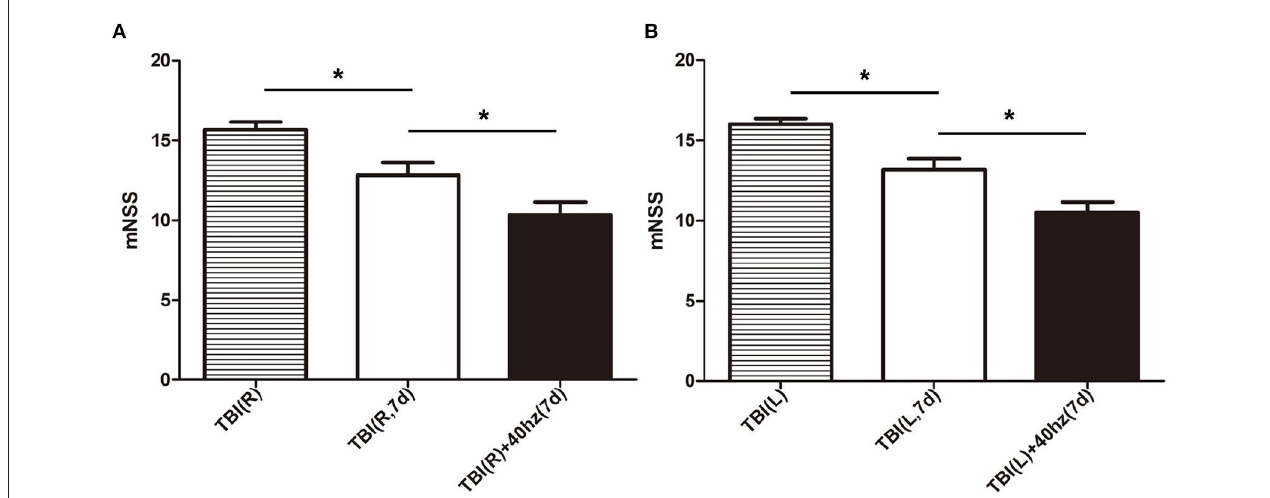
FIGURE 6 | The mNSS in different subgroups. (A) The mNSS evaluated of right-side TBI group. The stripe, white and black bar represent for TBI (R), TBI (R, 7d) and TBI (R) + 40hz light (7d), respectively. (B) The mNSS evaluated of left-side TBI group. The stripe, white and black bar represent for TBI (L), TBI (L, 7d), and TBI(L) + 40hz light (7d), respectively. P -values correspond to one-way ANOVA. Data are expressed as mean ± SEM. * P < 0.05.